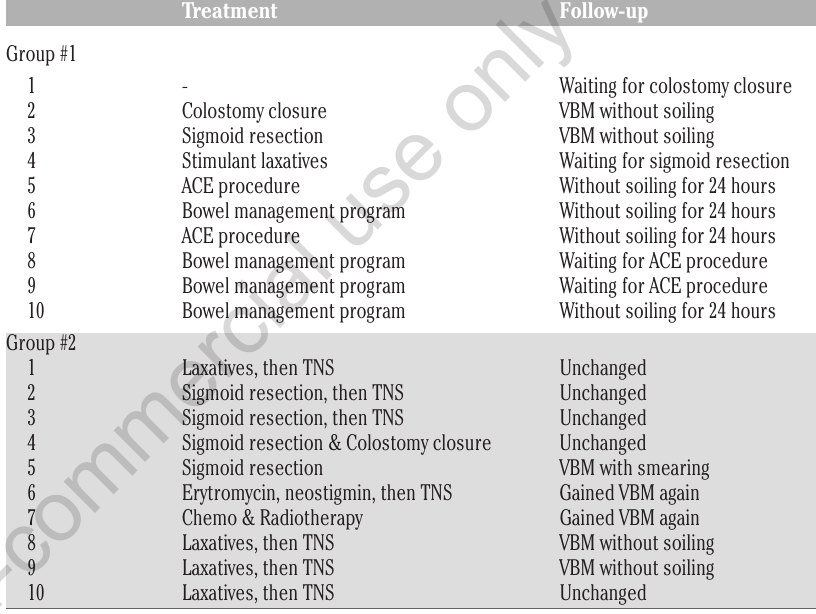
Table 5. Clinical follow-up of the